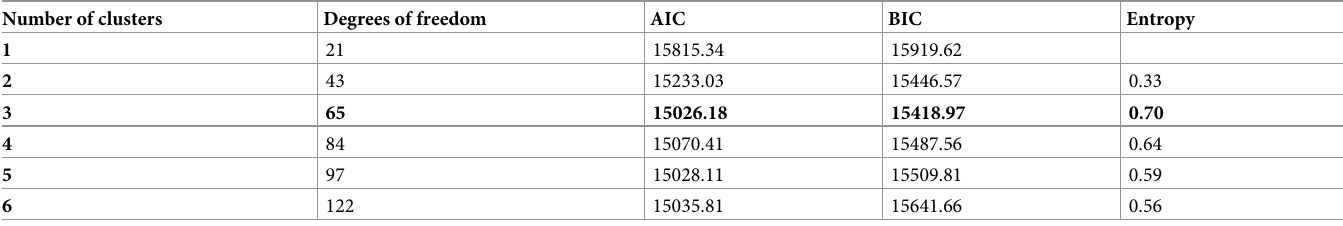
Table 1. Model fit information for the latent class models from 1–6 clusters (n = 1060). Number of clusters